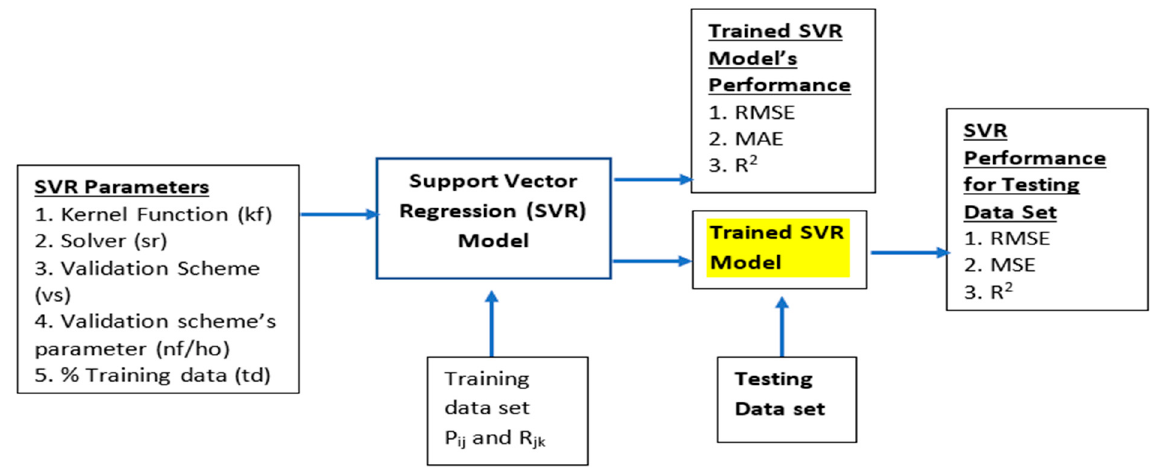
Figure 2. Evaluation of one moth. Table 5. Parameters of MFO, DFO and PSO algorithms [24].